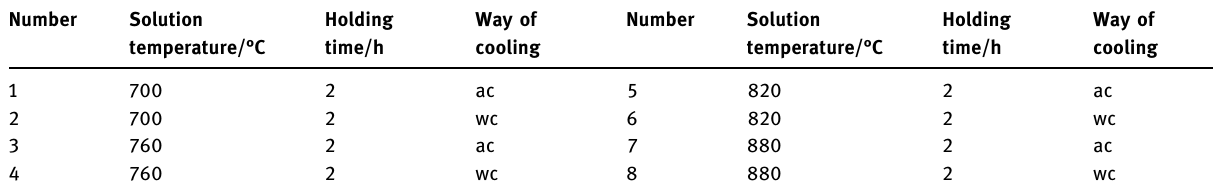
Table 1: Experiment program of solution treatment for TB6 alloy